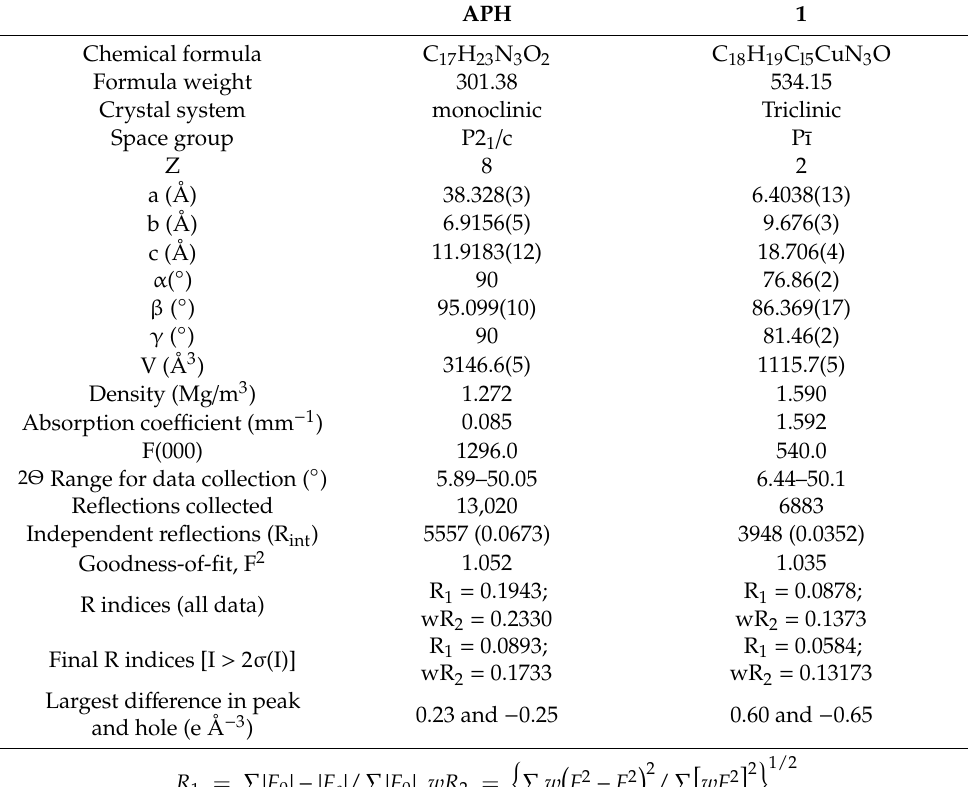
Figure 4. Molecular plot of APH shows the different intermolecular interactions between APH and water moieties. Only one asymmetric unit interaction is shown, as the other unit is symmetrically